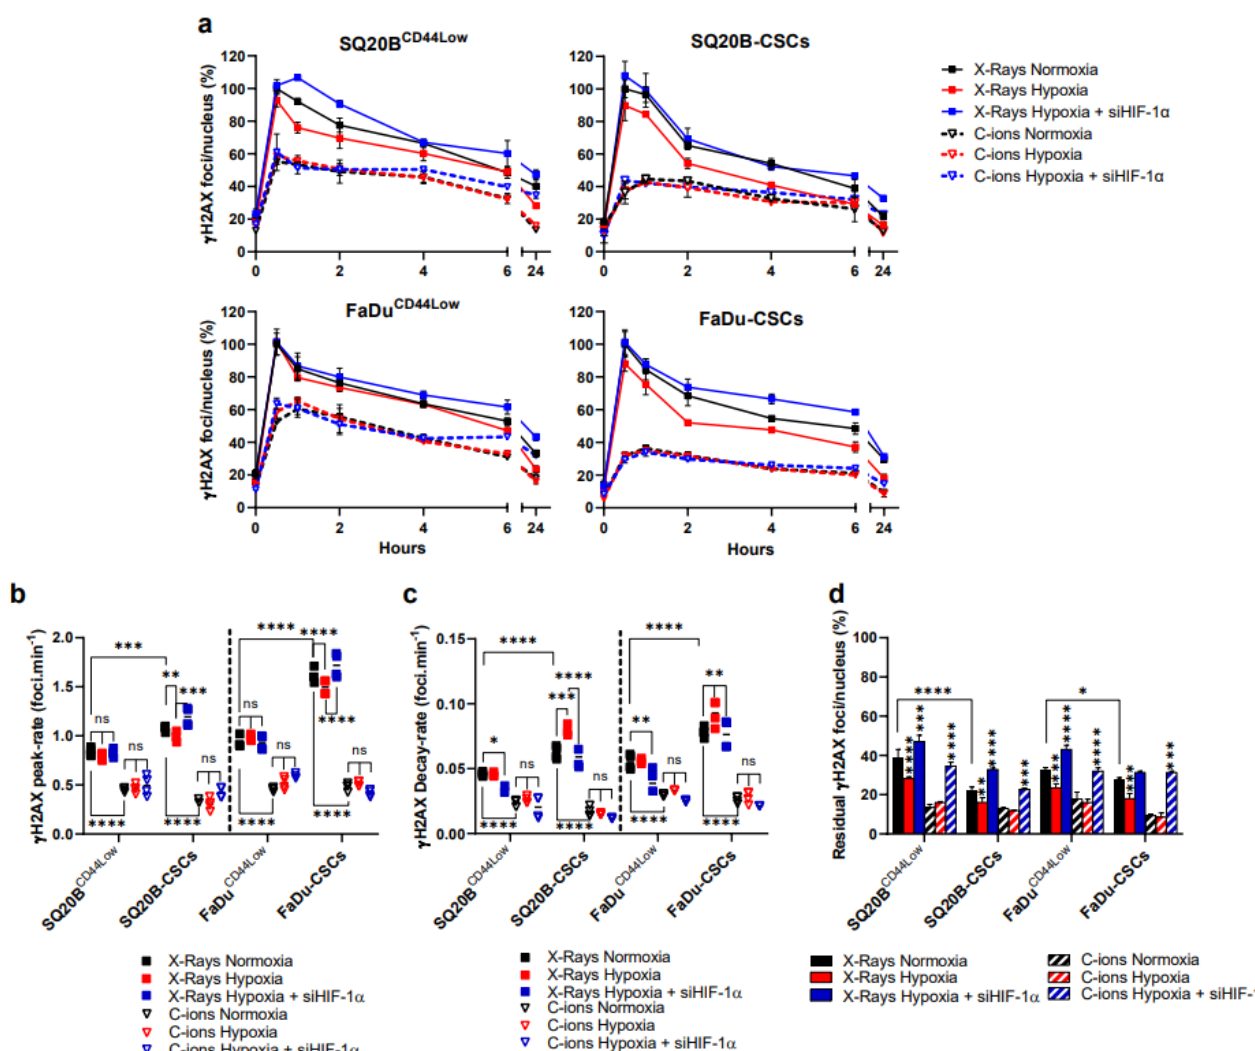
Figure 3. Silencing HIF-1 α under hypoxia increases the residual detected DSBs in response to both irradiations. ( a ) Kinetics of γ H2AX foci after X-Rays and C-ions, ± siHIF-1 α . The percentages of foci per nucleus were calculated for each condition considering the X-Ray normoxic peak as the reference (means ± SD). ( b , c ) represent respectively the peak-rate from basal levels and decay-rate from peak to 6 h, as determined from the data shown in ( a ) (two-way ANOVA test, * p < 0.05, ** p < 0.01, *** p < 0.001, **** p < 0.0001, ns: non-significant). ( d ) Residual foci were quantified at 24 h and each condition was statically compared to their respective normoxic condition (two-way ANOVA test) ( n = 3).